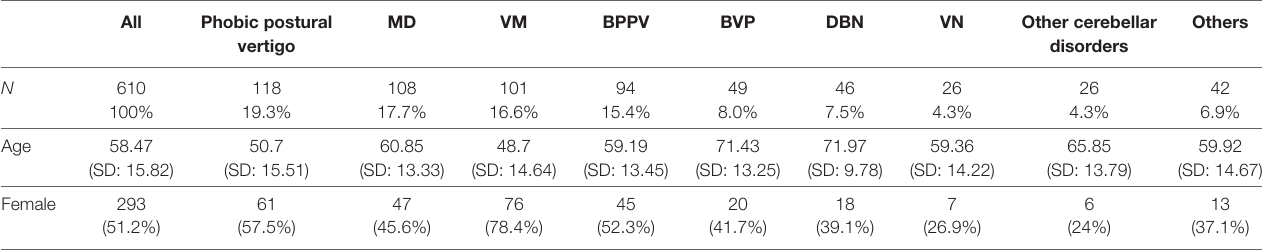
TaBle 2 | Clinical characteristics of diagnosis of study